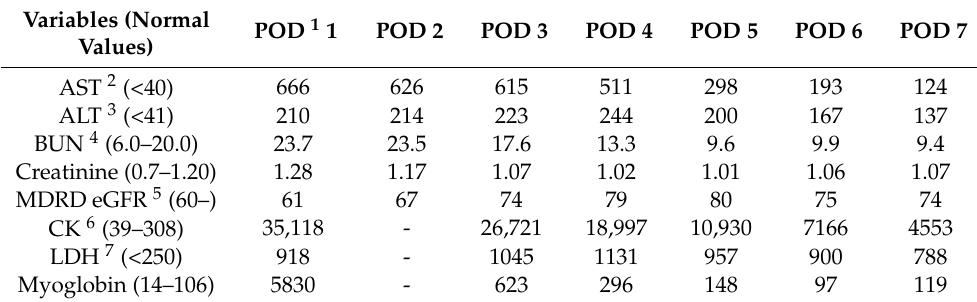
Table 1. Sequential laboratory values after surgery.